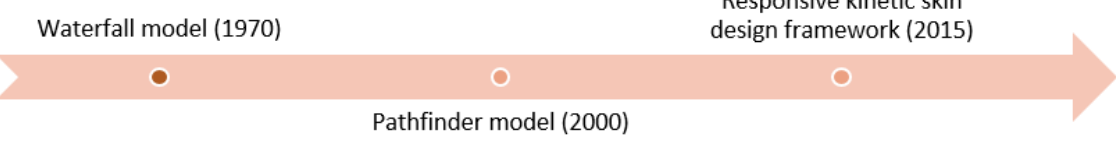
Figure 8. Chronological order of the theoretical framework (source: author)